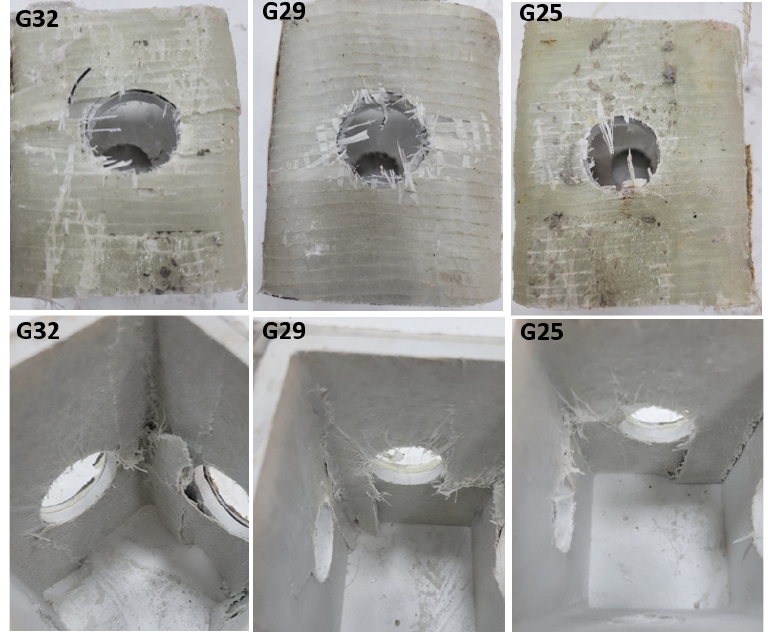
Figure 11. Damage photos of the C32, C29, C25, and C22 specimens.